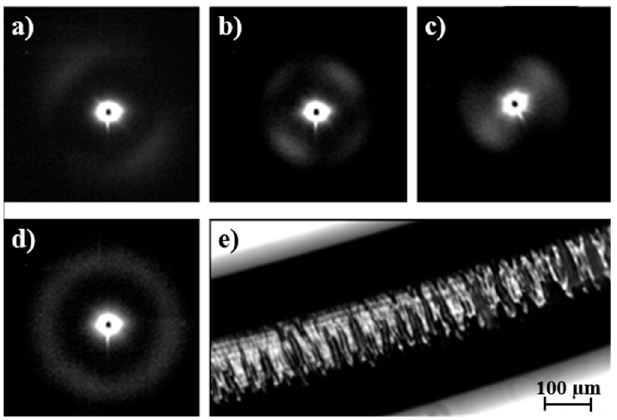
Figure 13. SAXS patterns taken at representative temperatures of 25 °C ( a ); 102 °C ( b ) and 107 °C ( c ) during a heating run at 10 °C/min of a PDO suture previously degraded in a pH 11 hydrolytic medium for 36 days. The pattern obtained at room temperature after cooling (10 °C/min) and the optical micrograph of the degraded suture are shown in ( d , e ), respectively.